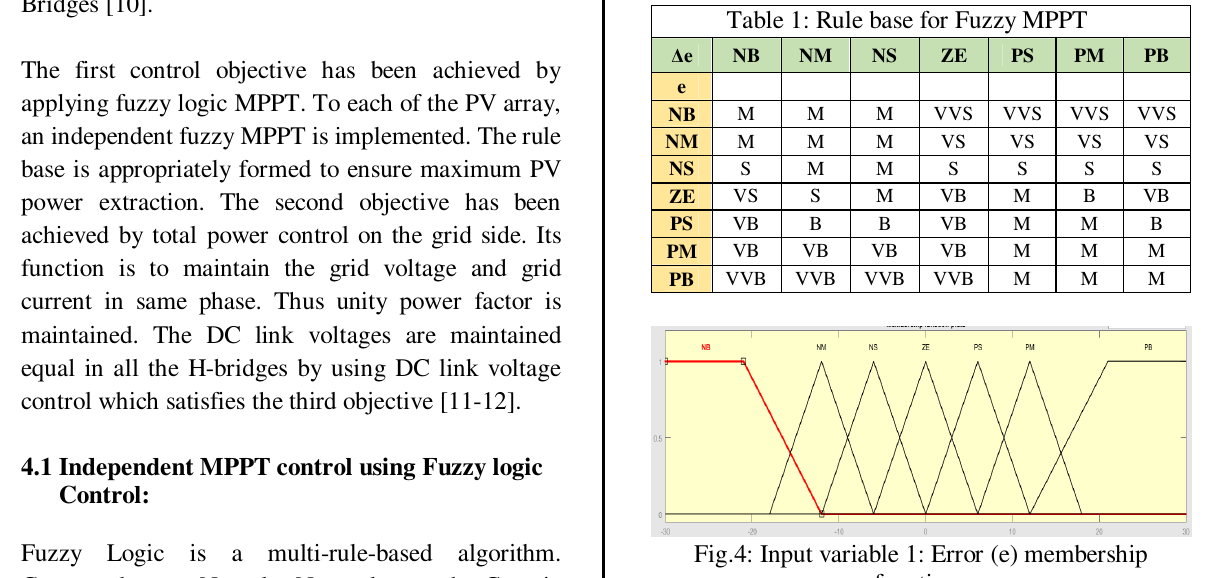
Fig.4: Input variable 1: Error (e) membership